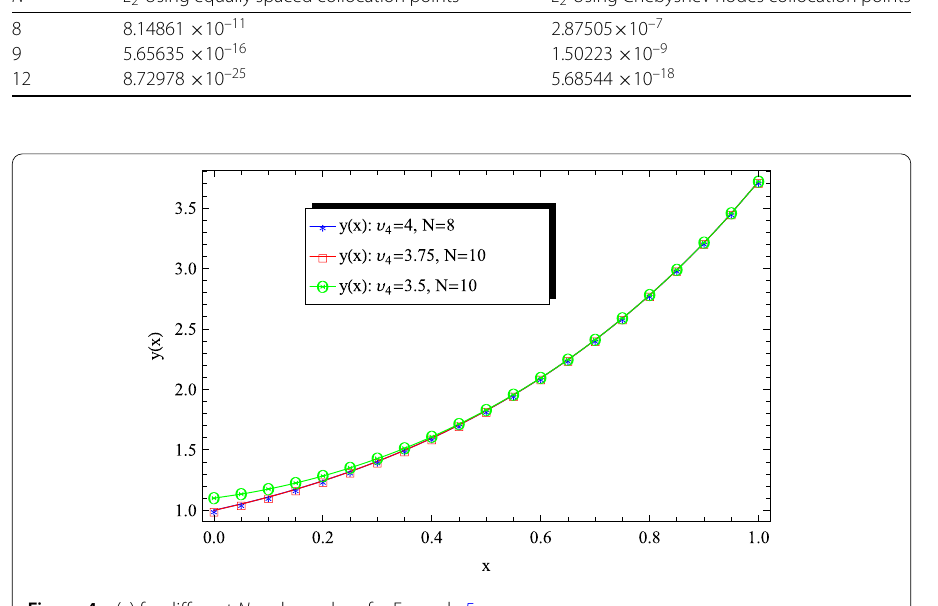
Figure 4 y ( x ) for different N and ν 4 values for Example 5